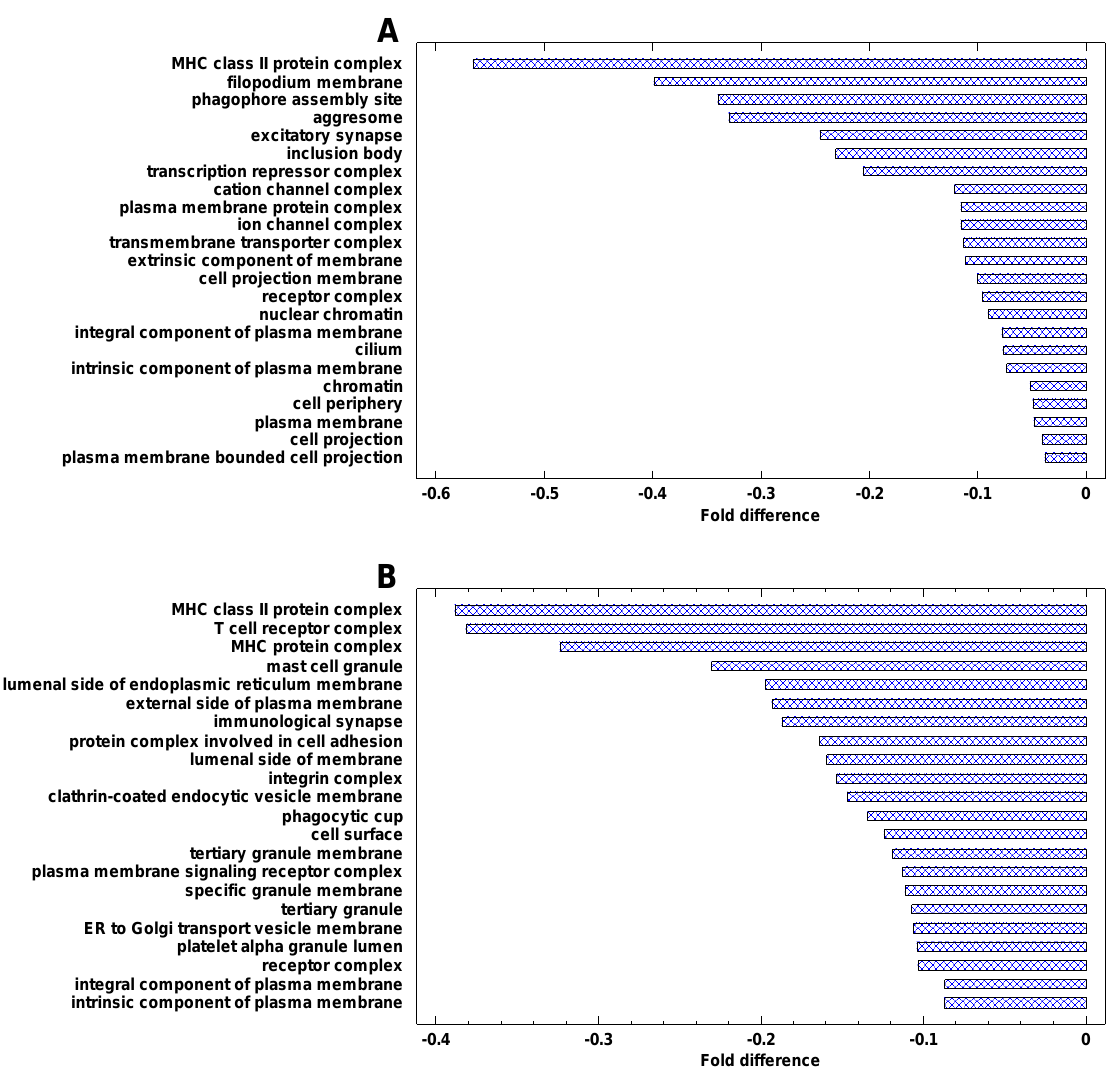
Figure 9. The most strongly enriched GO Cell Components in the genes that are downregulated in the invasive and polyploid cancers. Fold difference: the difference between the mean cancer/normal expression fold for a given cell component and the mean fold for all cell components (log2). The components with the highest folds (and having >10 genes) are shown: ( A ) invasive/non-invasive fold (myeloma) ( p < 0.01 at least); ( B ) polyploid/diploid fold ( ‘ pancancer ’ , i.e., the data integrated over about 10,000 cancer samples) ( p < 0.0001 at least).